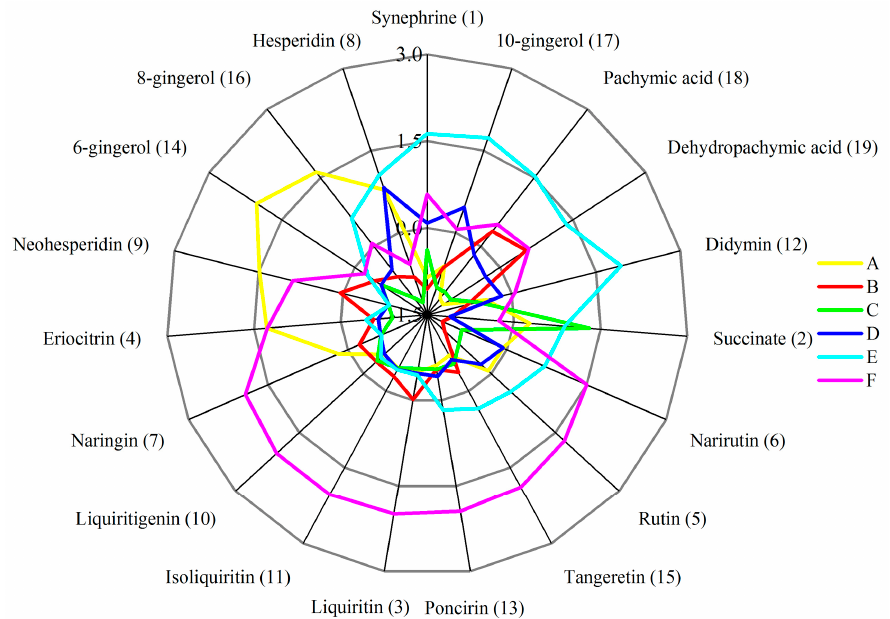
Figure 6. The radar chart of z-score normalized data of 19 chemicals contents in a daily dose of WDD prepared in the lab and its five brands commercial preparations. The average contents of the 19 chemicals in a daily dose of the six WDD preparations is provided in Table 4.